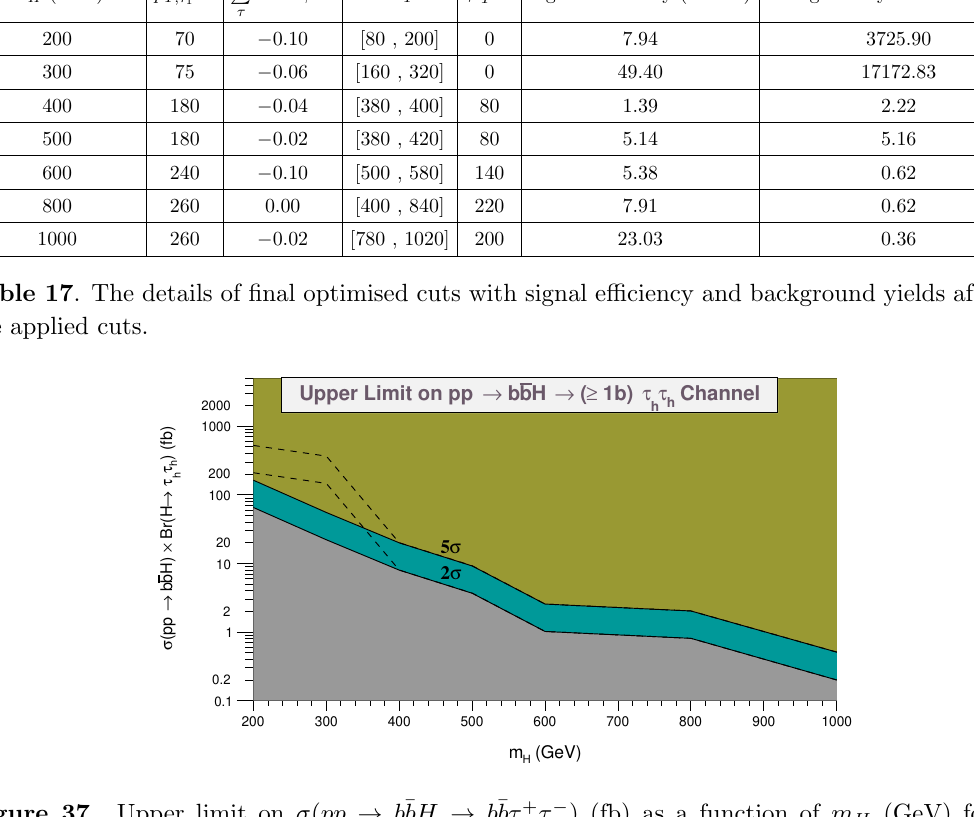
b (cid:22) bH b (cid:22) b(cid:28) + (cid:28) (cid:0) ) (fb) as a function of m H (GeV) for the ! !